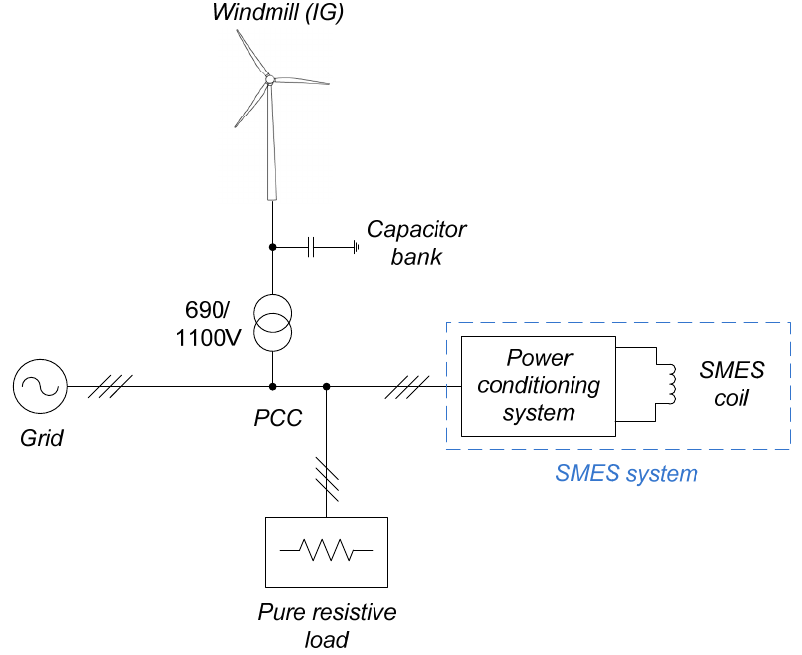
Figure 2. Schematic representation of the system under investigation.